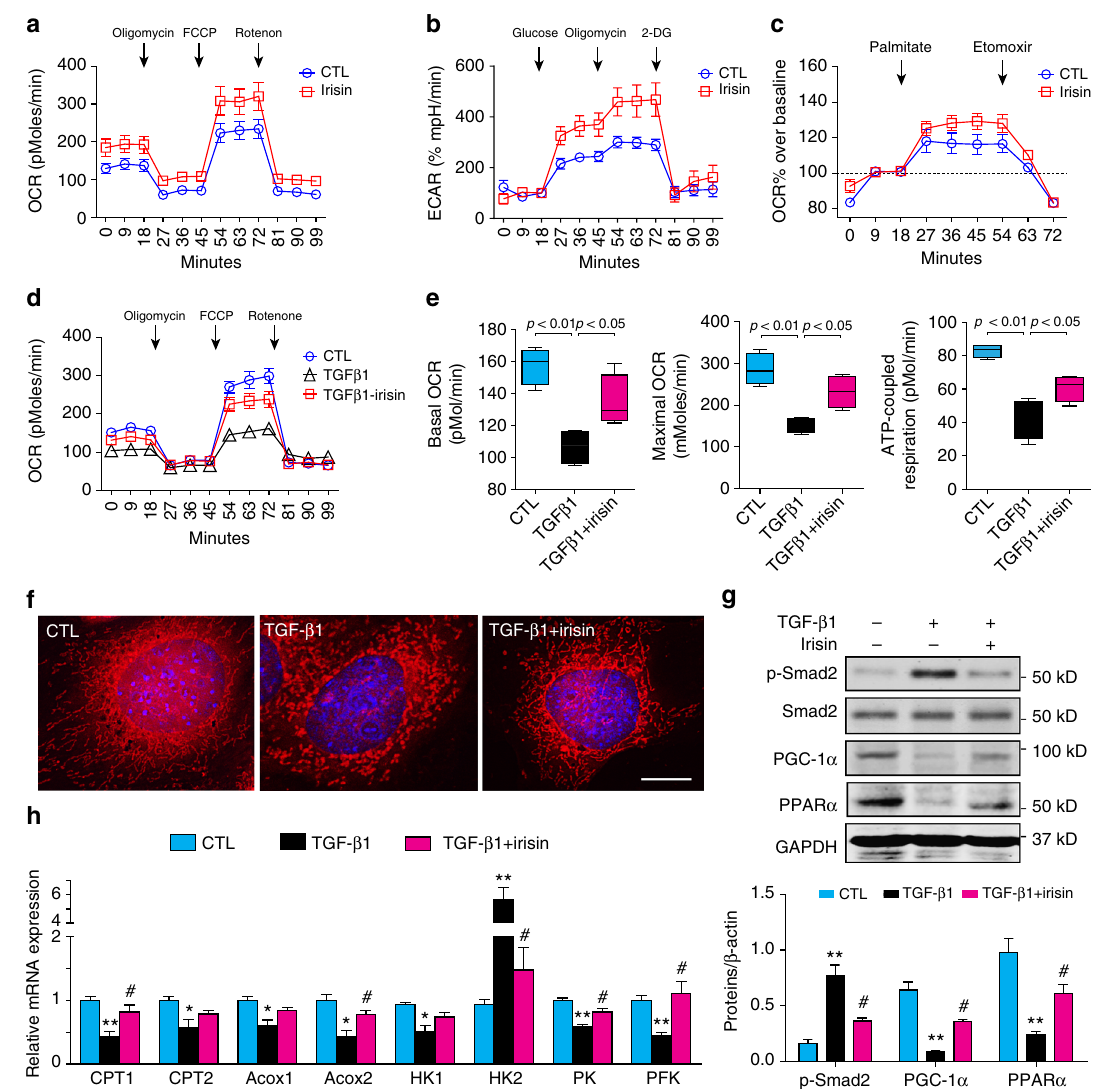
Fig. 5 Recombinant irisin counteracts TGF- β 1-induced metabolic reprogramming in primary tubule cells. a – c Primary tubule cells cultures were treated with recombinant irisin (2 μ g ml − 1 ) for 12 h, cell respiration was examined with mito-stress assay a , glycolysis assay b and Fatty acid assay c . CTL: control, with no addition of irisin. d , e Cell respiration of tubule cells treated with TGF- β 1(2 ng ml − 1 , for 12 h) or pretreated with irisin before adding TGF- β 1. Statistical analysis of basal OCR, maximal respiration and ATP-coupled respiration ( n = 5 per group, one-way ANOVA with Bonferroni ’ s multiple comparison test). f Mitochondria morphology was examined with mito-tracker staining after tubule cells treated with TGF- β 1 or TGF- β 1 plus irisin. Scale bars, 10 μ m. g Western blot showing the expression of Smad2, PPAR α and PGC-1 α in tubule cells treated with TGF- β 1 or TGF- β 1 plus irisin. Quantitative measurements of Smad2, PPAR α and PGC-1 α protein expression in each group as indicated. ** P < 0.01 for TGF- β 1 vs. CTL, # P < 0.05 for TGF- β 1 + irisin vs. TGF- β 1 treated group ( n = 5 per group, one-way ANOVA with Bonferroni ’ s multiple comparison test). h Real-time qPCR showing irisin counteracts TGF- β 1-induced suppression of enzymes in energy metabolic pathways. Data were presented as mean ± s.e.m.; * P < 0.05 or ** P < 0.01 for TGF- β 1 vs. CTL. # P < 0.05 for